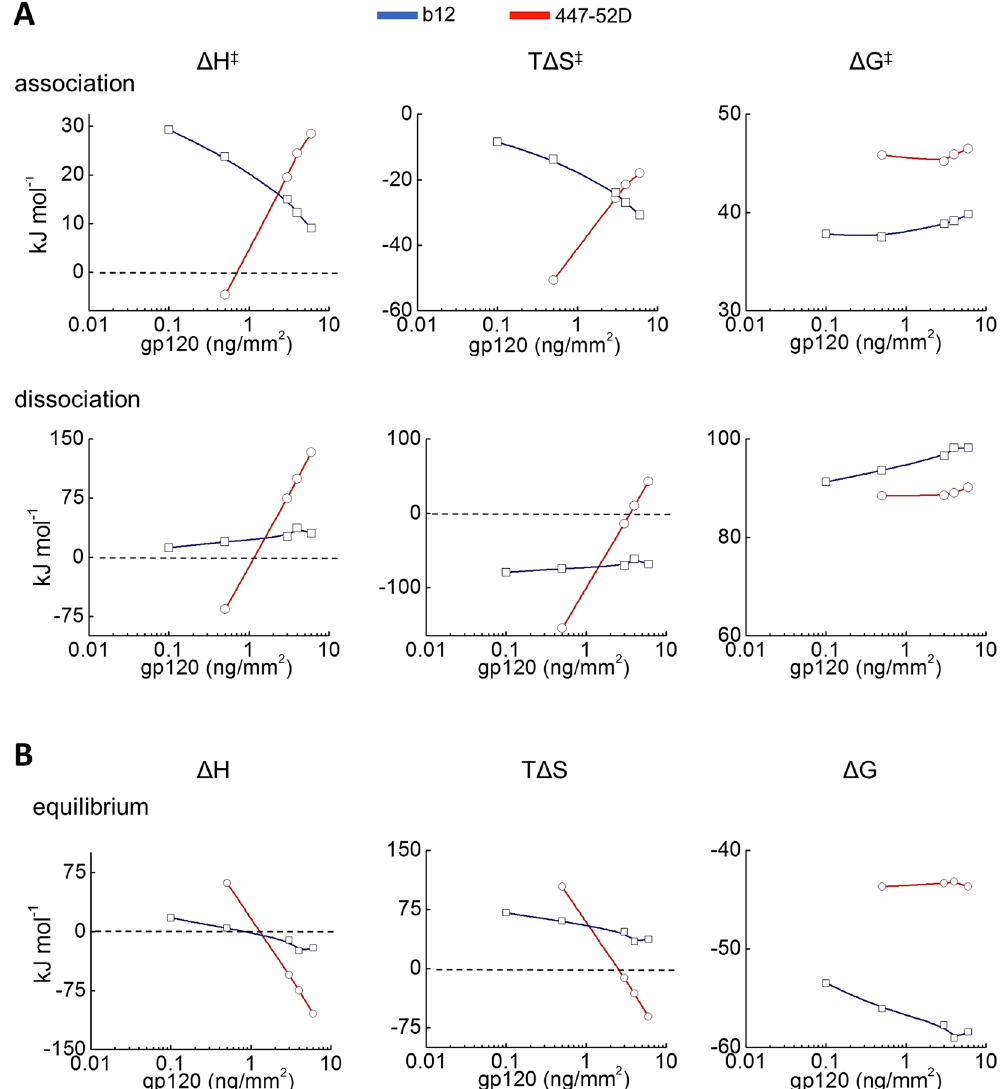
Figure 3. ( A ) Effect of density of surface-bound antigen on the activation thermodynamics of b12 (blue lines and symbols) and of 447-52D (red line and symbols). The values of the thermodynamic parameters were calculated by Eyring’s analyses using slopes of Arrhenius plots depicted on Fig. 2. All thermodynamic parameters were calculated at a reference temperature of 25 °C (293.7 K). ( B ) Effect of density of surface- bound antigen on the equilibrium thermodynamics of b12 (blue lines and symbols) and 447-52D (red line and symbols). The values of the thermodynamic parameters were evaluated as described in the experimental procedures. All equilibrium thermodynamic parameters were calculated at a reference temperature of 25 °C (293.7